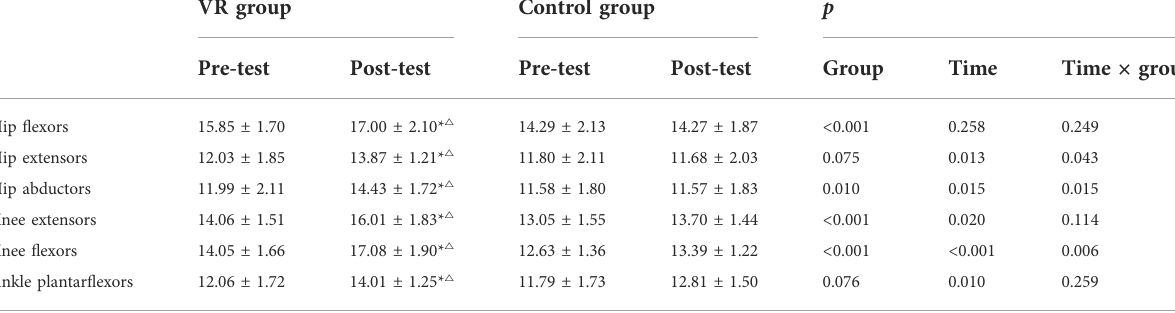
TABLE 4 The results of the lower limb muscle strength in adolescents with ID